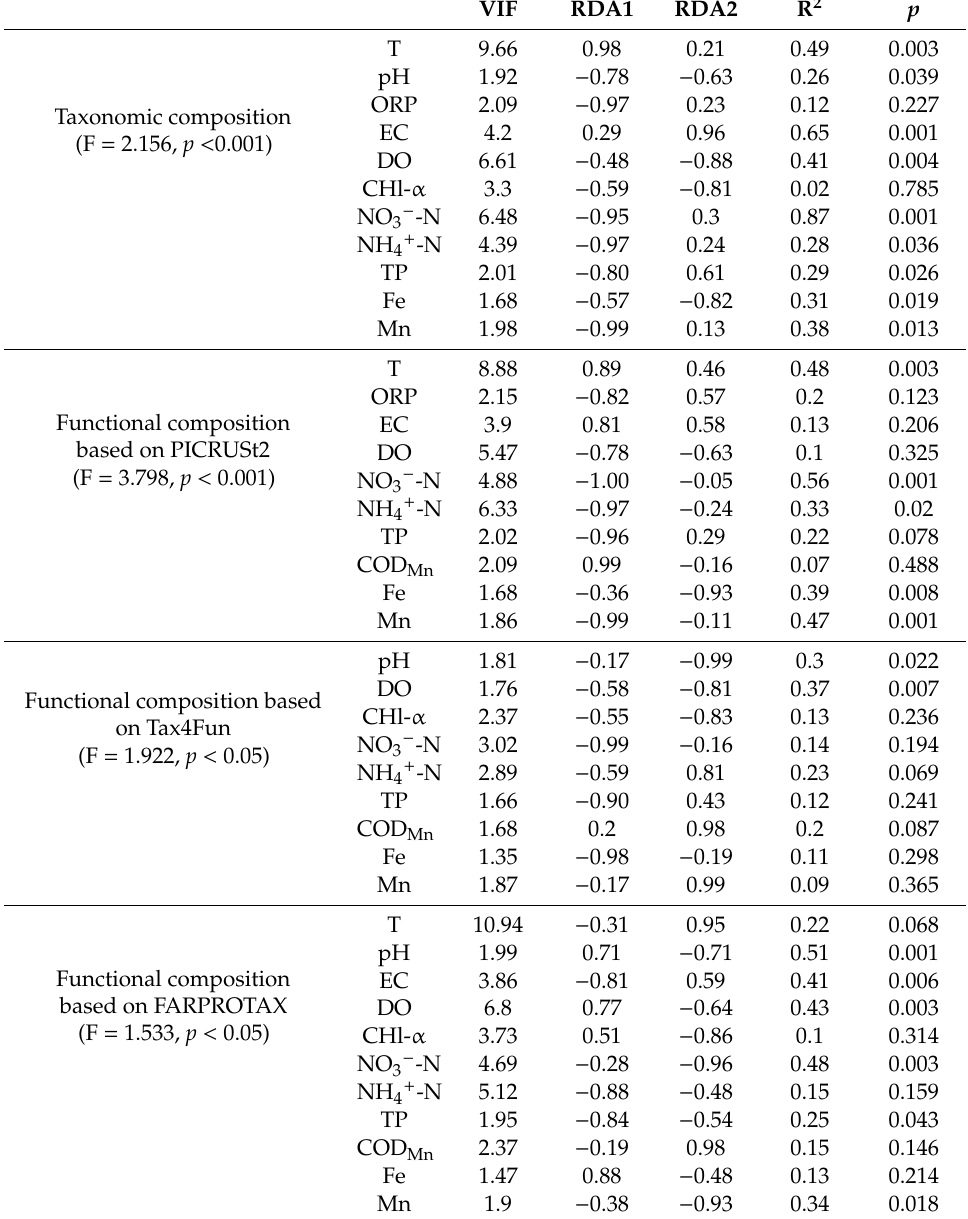
Table 1. Community variances explained by environmental factors of microbial community and function community, respectively, in Baiyangdian Lake. VIF RDA1